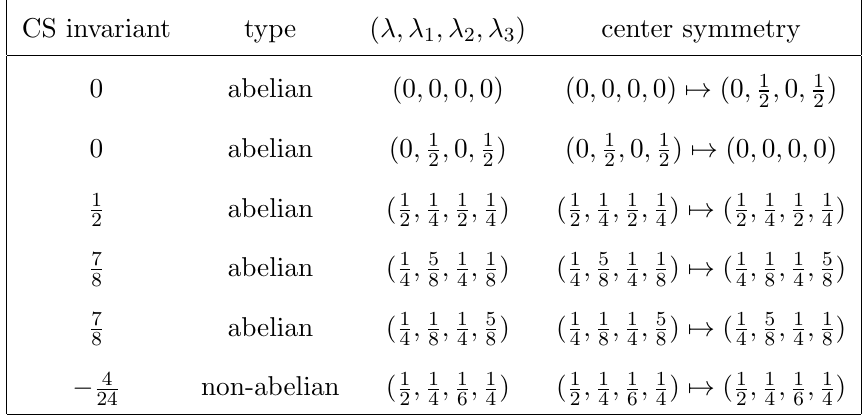
Table 6 . Holonomy variables and Chern-Simons invariants of SU(2) (cid:13)at connections on M ( 2; 1 ; 1 ; 1 ), along with the action of center symmetry on 2 3 2 (cid:0)